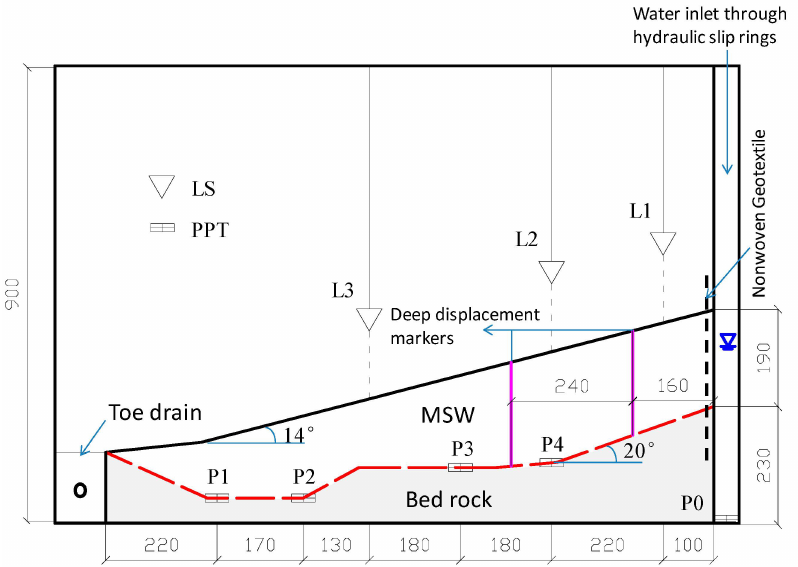
Figure 13. Experimental setup of model slope (Note: all dimensions are in